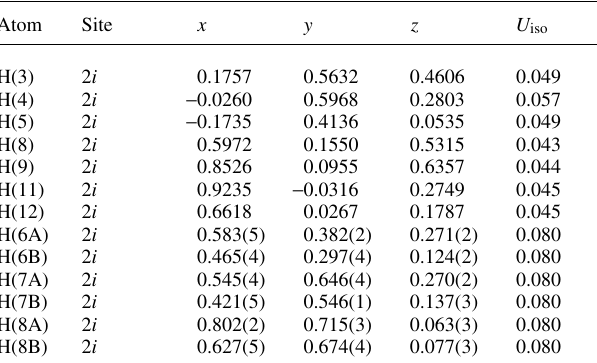
Table 2. Atomic coordinates and displacement parameters (in Å 2 ) .